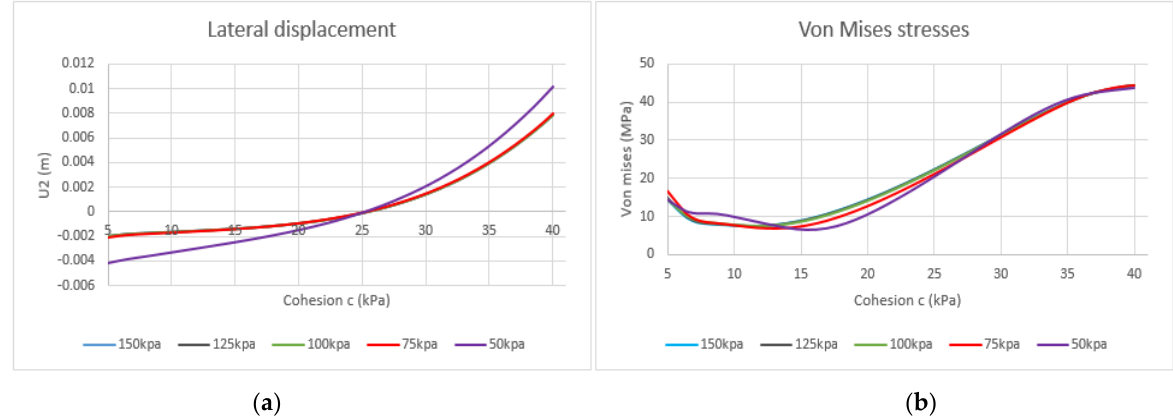
Figure 17. Influence of cohesion C of soil: ( a ) Lateral displacements, ( b ) Von Mises stresses.